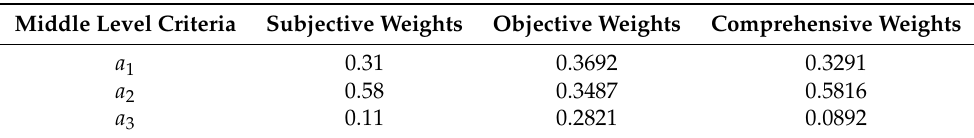
Table 8. Objective and comprehensive weights of middle level criteria.